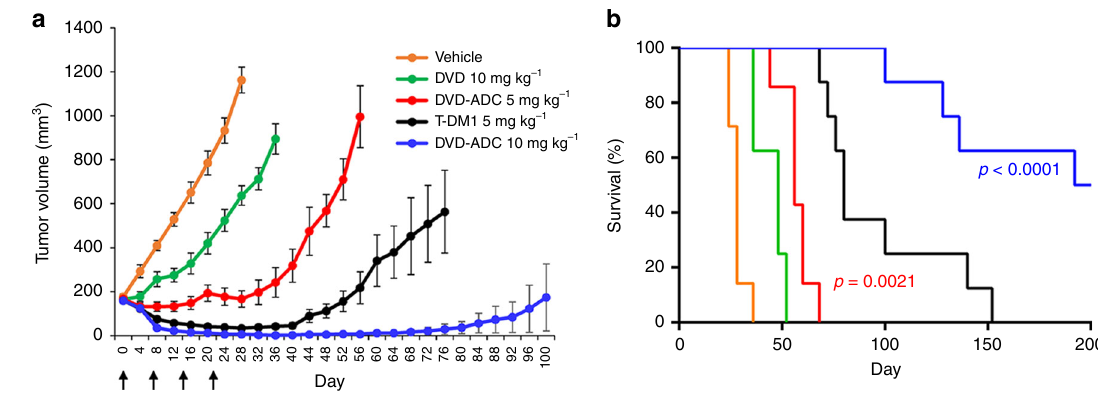
Fig. 3 In vivo ef fi cacy of anti-HER2 DVD-ADC. a Human BC cell line KPL-4 was xenografted into the mammary fat pads of female NSG mice, grown to ~150 mm 3 , randomized into fi ve groups comprising seven or eight mice each, and treated with i.v. (tail vein) injections of the indicated ADCs and controls once a week for 4 weeks. The benchmark ADC, T-DM1 (black), was used as a positive control. Mean ± SEM values are plotted. When compared with a t -test (one-tailed, unpaired, uneven variance), the 5 mg kg − 1 (red) and 10 mg kg − 1 (blue) DVD-ADC groups were signi fi cantly different from the 10 mg kg − 1 DVD group (green) on day 8 ( p = 0.0046 and p = 0.00016, respectively) until the last common data point on day 36 ( p = 0.0000069 and p = 0.0000019, respectively). b Corresponding Kaplan − Meier survival curve with p -values (log-rank (Mantel-Cox) test) comparing survival between anti-HER2 DVD-ADC groups (red and blue) and the unconjugated anti-HER2 DVD group